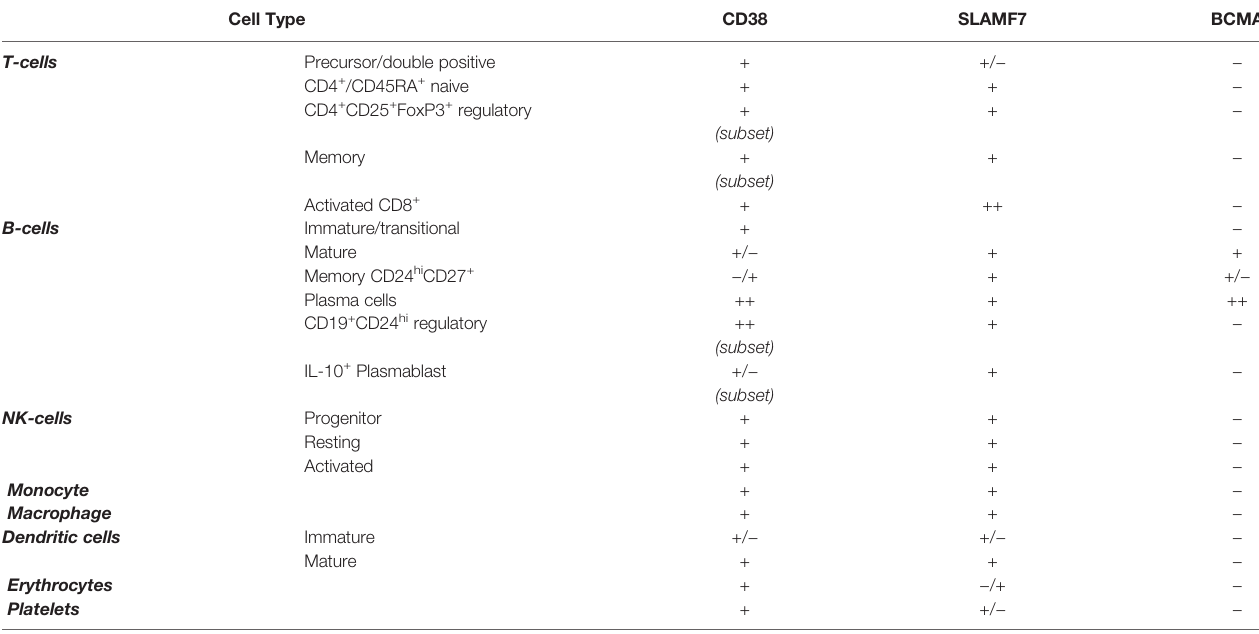
TABLE 1 | Expression of CD38, SLAMF7, and BCMA in cells circulating in peripheral